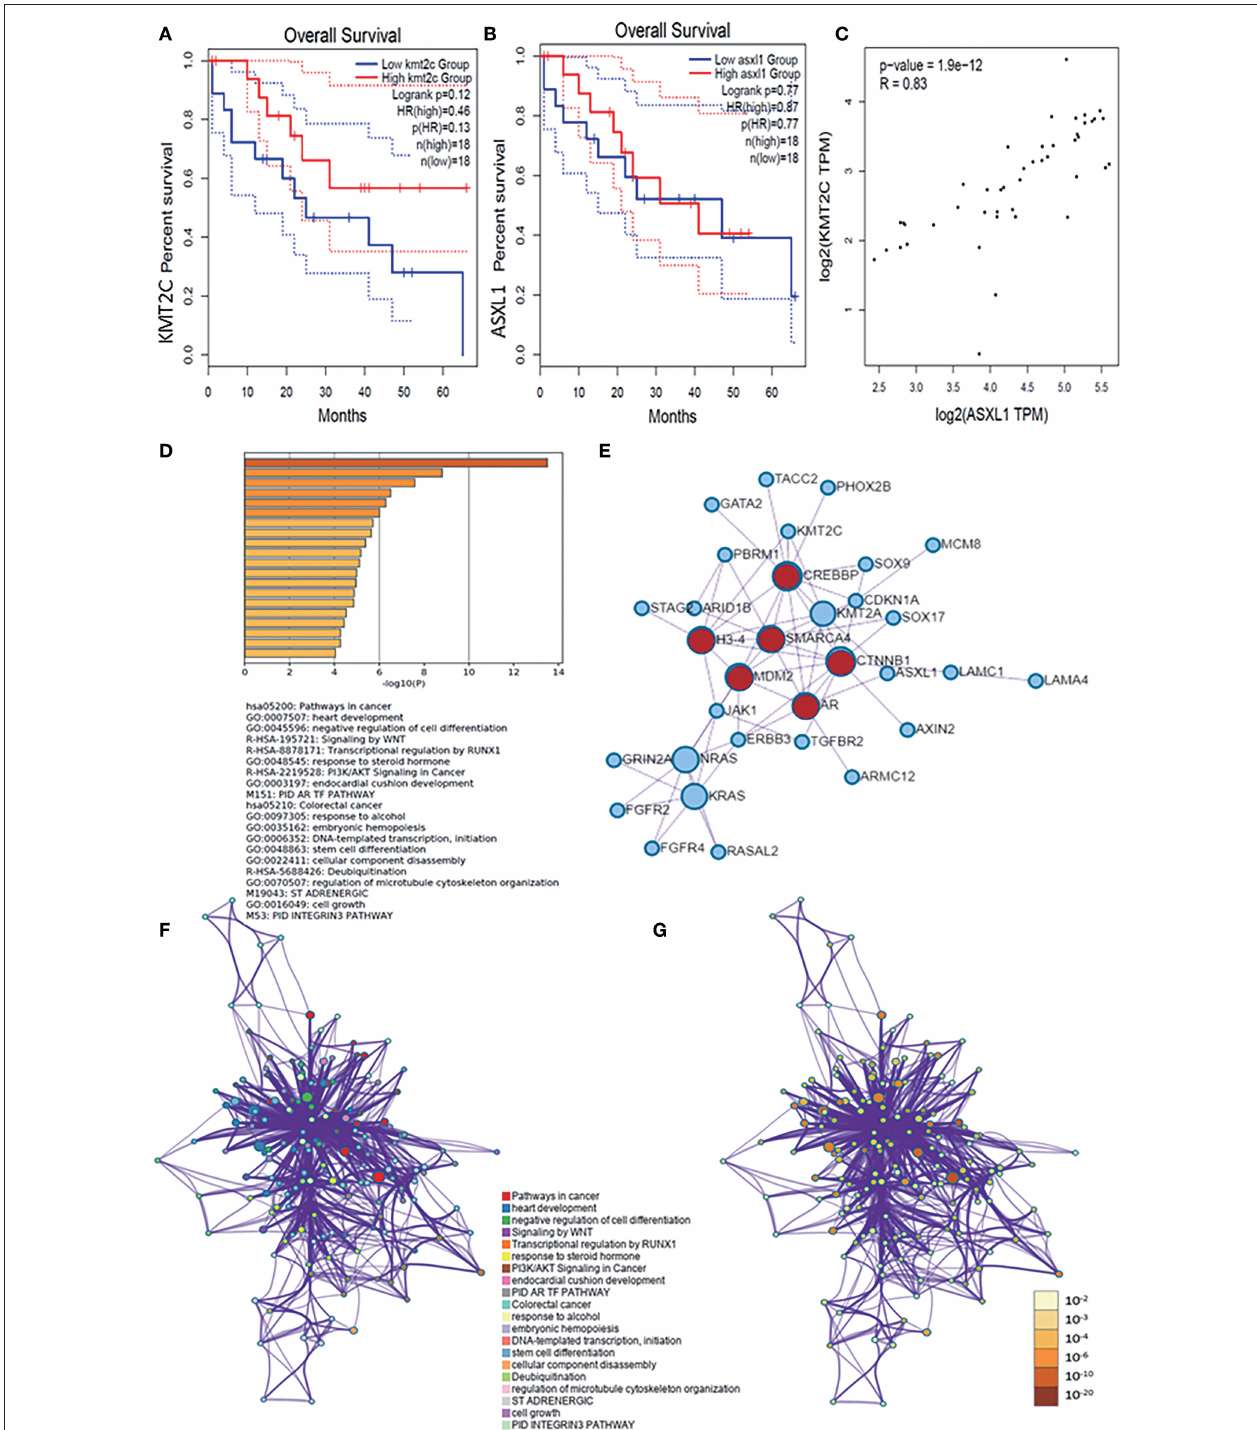
FIGURE 3 | (A,B) Survival analysis based on the expression status of KMT2C and ASXL1 and a Kaplan-Meier curve was plotted. (C) Correlations of KMT2C and ASXL1 in CCA. (D) Bar graph of enriched terms across these enriched genes in AYAs with CCA, colored by p -values. (E) Protein–protein interaction network and MCODE components identified in the genes enriched in AYAs with CCA. (F,G) Network of enriched terms: (F) colored by cluster-ID, where nodes that share the same cluster ID are typically close to each other; (G) colored by p -value, where terms containing more genes tend to have a more significant p -value. ASXL1, additional sex combs like 1; AYA, adolescents and young adults; CCA, cholangiocarcinoma.